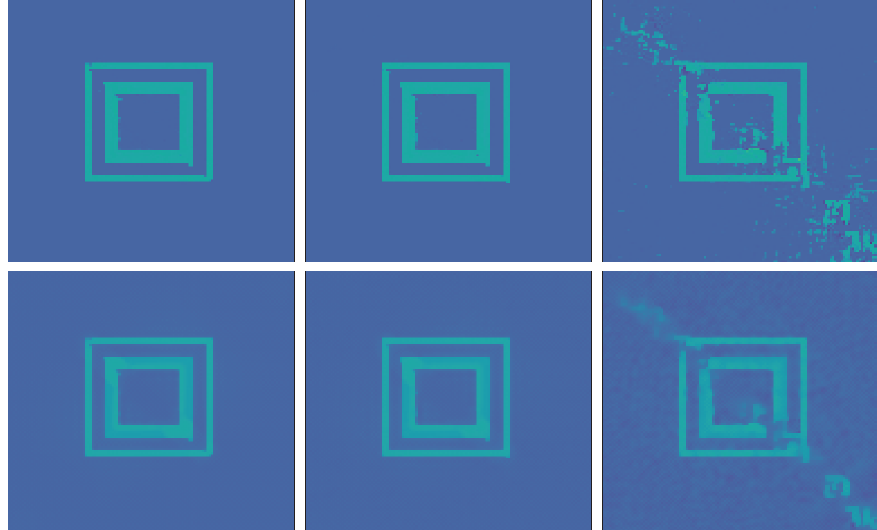
Figure 1. Top from left to right: phantom, masked phantom, and initial reconstruction A + A x . The difference between the phantoms on the left and the middle one shows the mask region I where no data is generated. Bottom from left to right: data without noise, low noise σ = 0.01, and high noise σ =